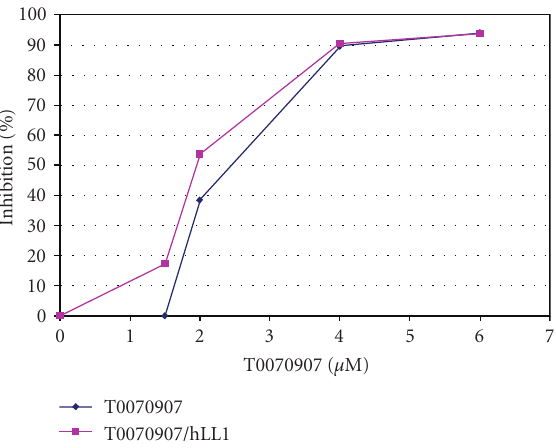
Figure 2: Dose-response curves for the MM line, KMS12-PE, to T0070907, both in the presence and absence of the hLL1 mAb. Square symbols represent the dose-response curve in the presence of hLL1, and diamond symbols represent the curve in the absence of LL1. The ordinate shows percent growth inhibition values and the abscissa the concentration of T0070907 in